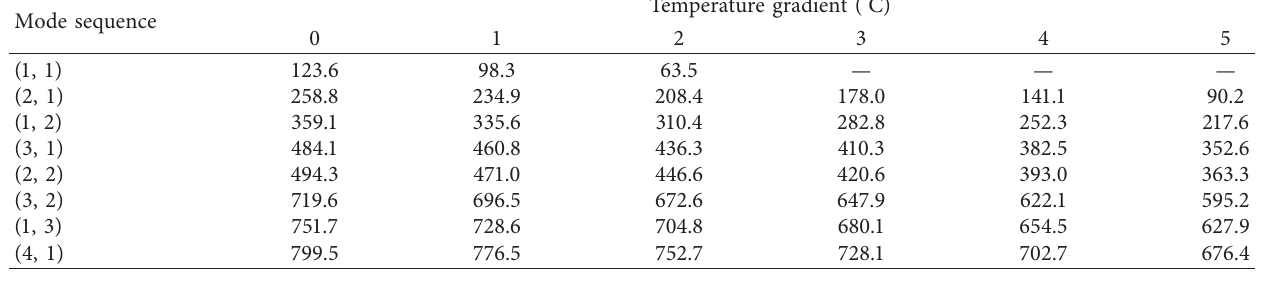
Table 3: Variation of natural frequencies with temperature.